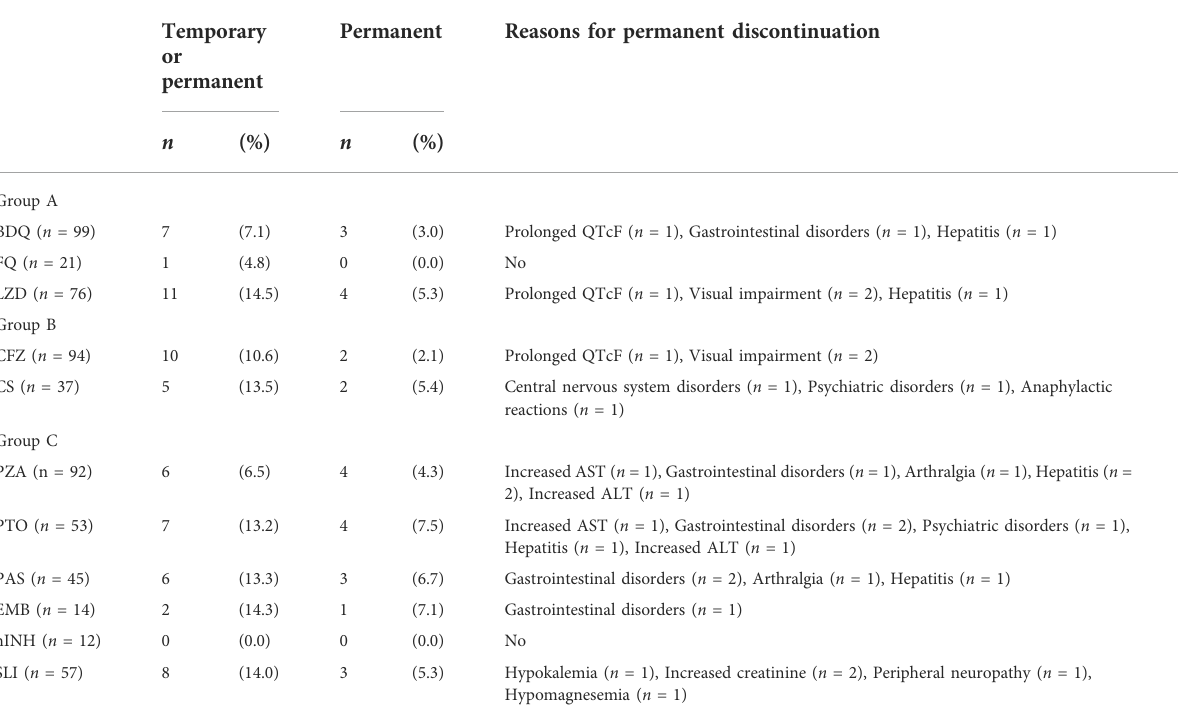
TABLE 4 Consequences of adverse